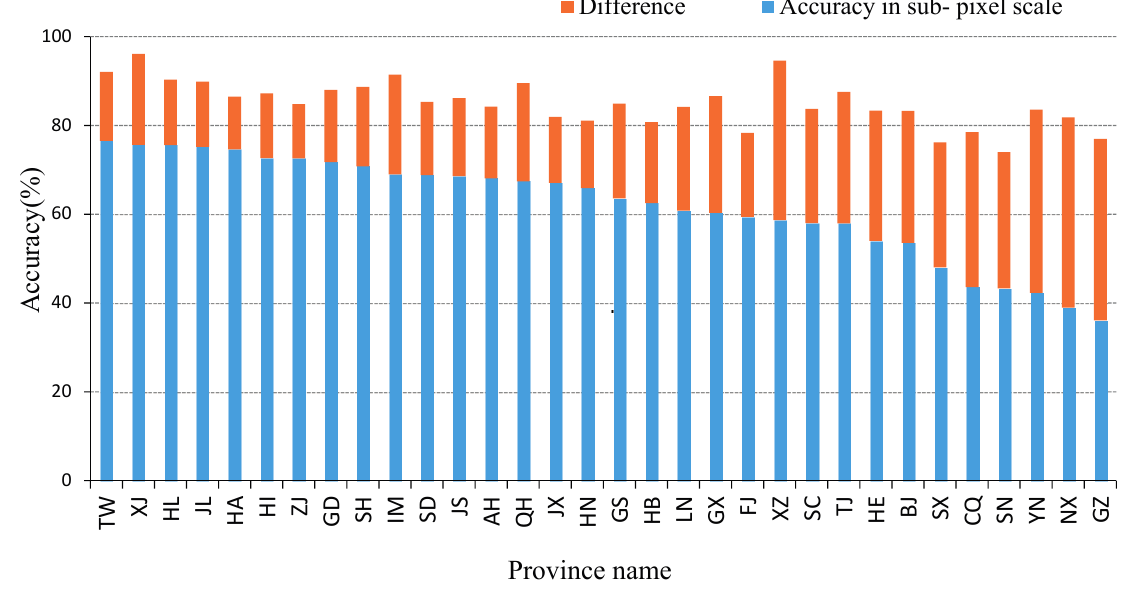
Figure 5. Accuracies at the sub-pixel scale and differences with the reference data (RDA) for the 32